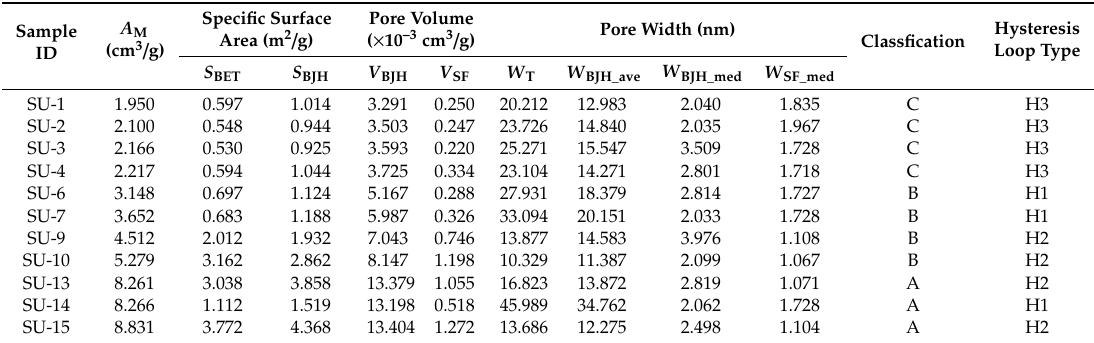
Table 2. Results of pores surface area, volume and pore width by N 2 adsorption / desorption experiment of He 8 Member tight